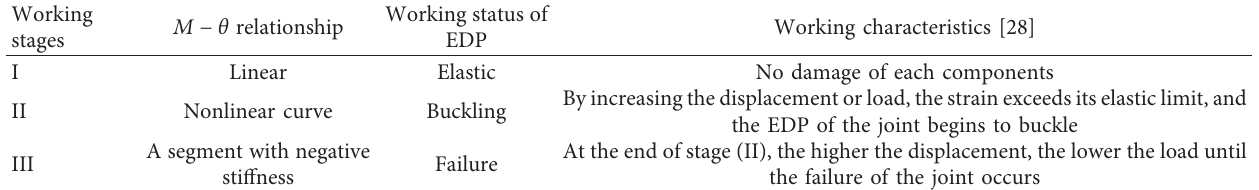
Table 3: Three working stages of a typical skeleton